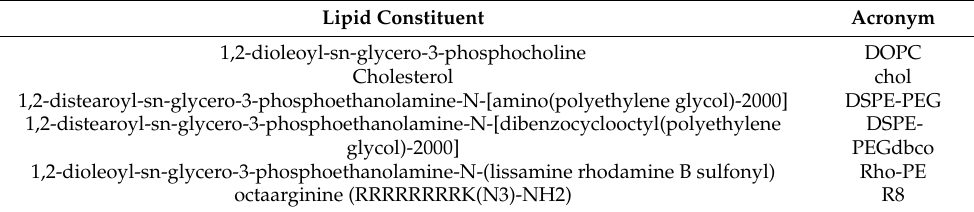
Table 2. PLP and R8-PLP Lipid Formulation Constituents.